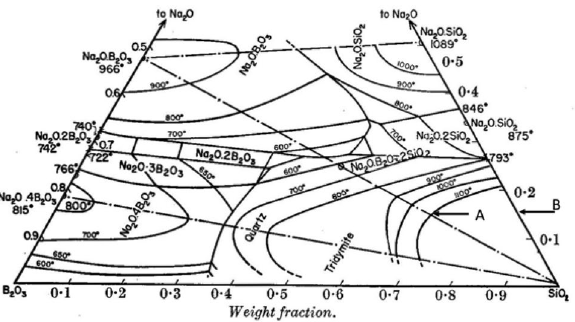
Figure 4. The phase diagram of the ternary system Na 2 O–B 2 O 3 –SiO 2 . Point A represents the glass with typical chemical compositions by weight % for borosilicate crown glass (15% Na 2 O, 15% B 2 O 3 , and 70% SiO 2 ); point B represents the sodium silicate glass with 15 wt.% of NaO 2 . Glass A and other borosilicate crown glasses with slightly various compositions have different liquidus temperatures compared with glass B. All these liquids solidify to the same tridymite crystal. Reproduced from Ref. 21